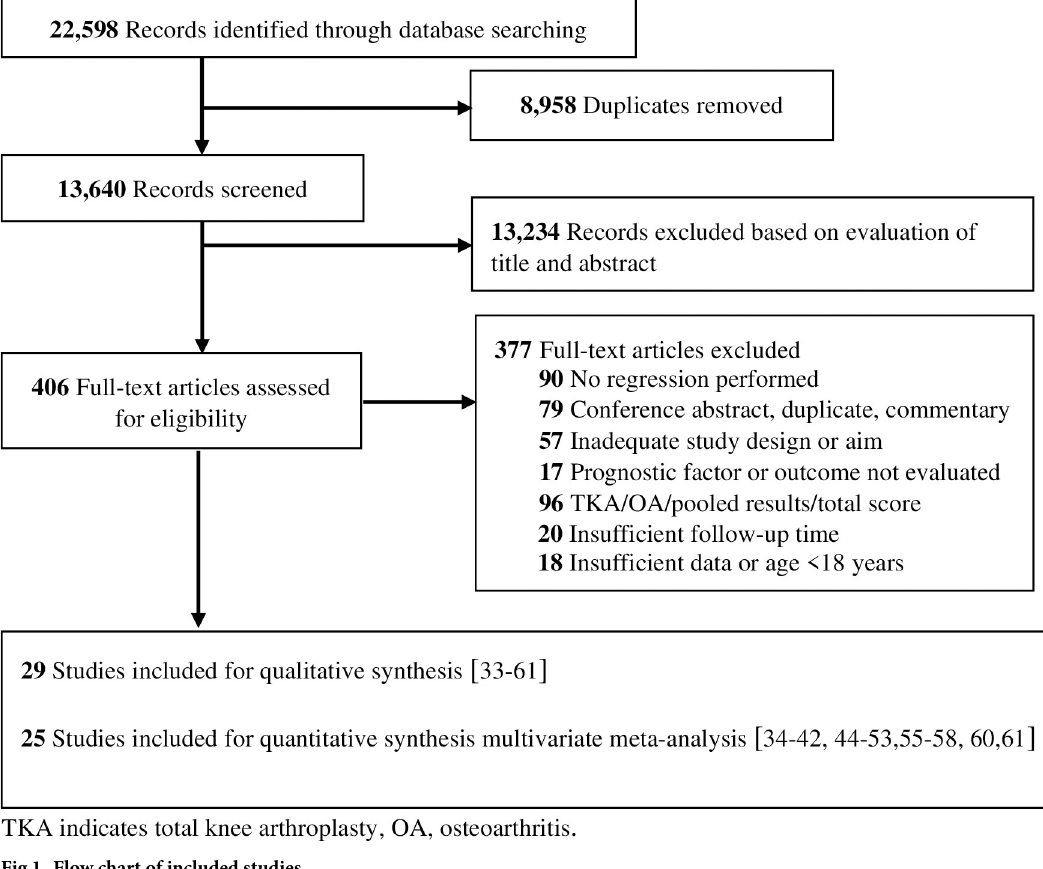
Fig 1. Flow chart of included